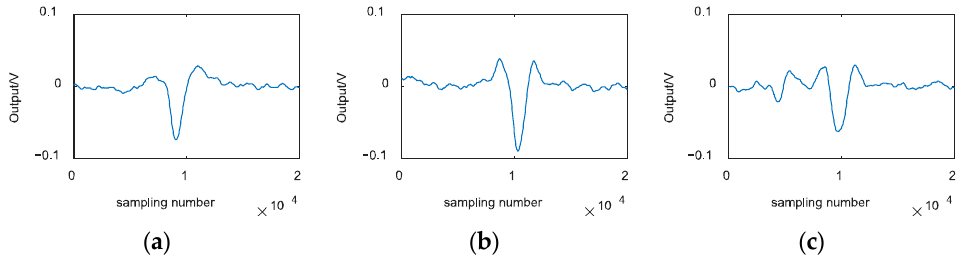
Figure 14. Experimental testing signal of B t for transverse cracks at different paths: ( a ) path A; ( b ) path B; ( c ) path C.